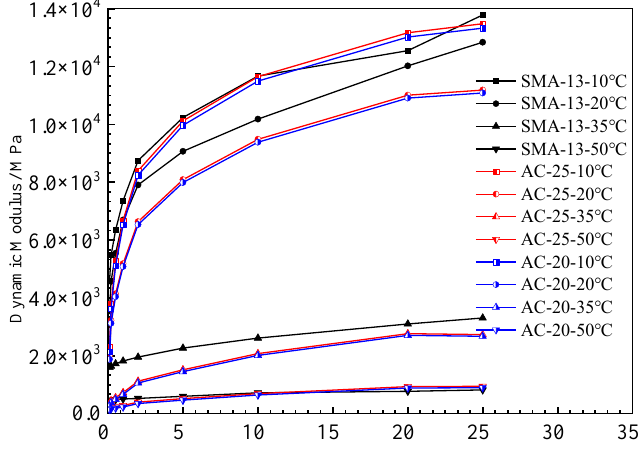
Figure 7. Dynamic modulus of asphalt mixtures.